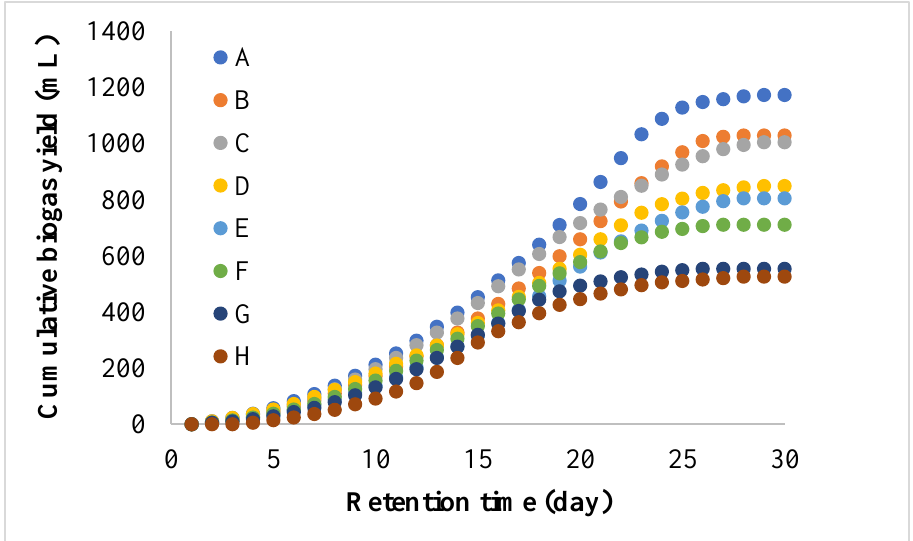
Figure 3. Cumulative biogas yield for bioreactors A (mF), B (NmF), C (CmF), D (TmF), E (ChTmF), F (CTmF), G (ATmF), and H (no MNM) of MNM loading of 1.5 g at 35 °C for 30 HRT.